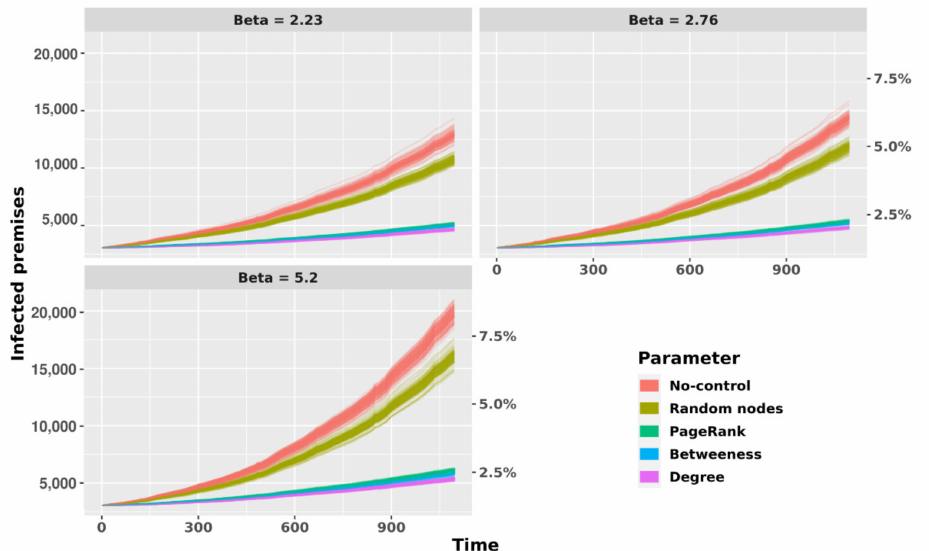
Figure 7. Predicted infection curves controlling by network-based control actions (removal of 25,000 premises based on different criteria) and without control action (No-control) in the temporal network representation of cattle movements for different probabilities of transmission (1, 2.76, and 5.2) using 3050 random nodes as initial infected premises in each simulation. The Y-left axis represents the total of infected premises at the end of simulation, and the y-right represent the percentage of infected premises. The x-axis represents the simulation time in